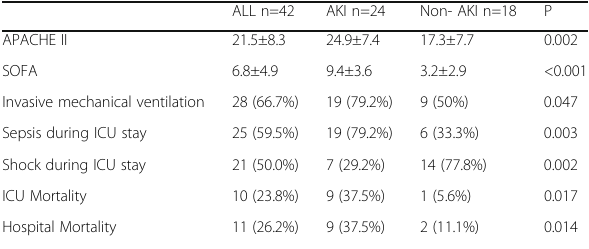
Table 1 (abstract 0410). Comparison of AKI and non-AKI patients